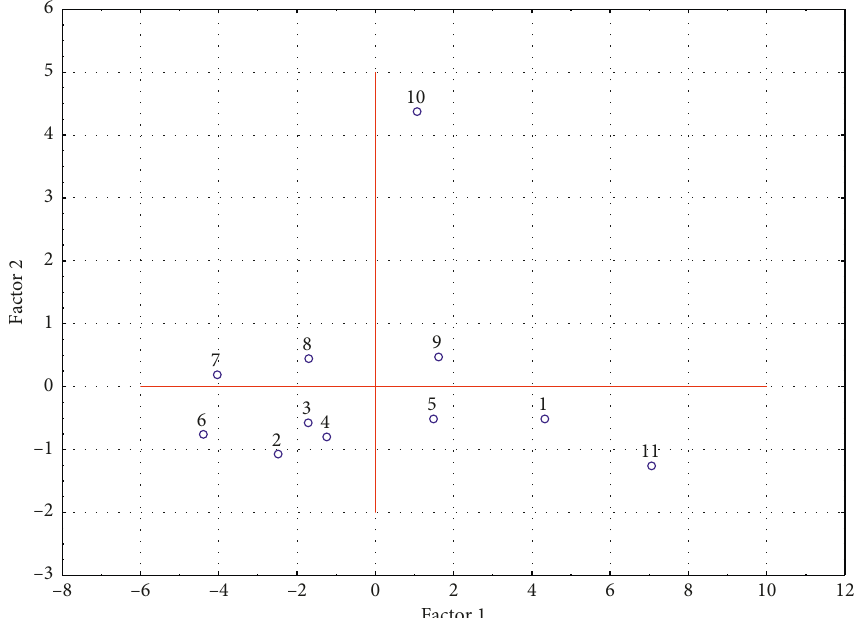
Figure 7: The distribution of cases (compounds) on the area of